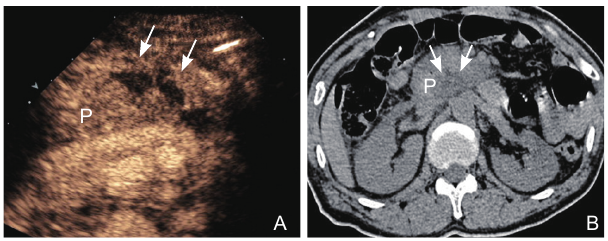
Figure 4 55-year-old man involved in a traffic accident. (A) CEUS identified the injury as an anechoic and hypoechoic perfusion defect with irregular borders in the pancreatic body/tail (arrows); (B) CT demonstrated the injury as a heterogenous, low-attenuation region (arrows) in the pancreatic body/tail, consistent with a hematoma and rupture of pancreas (P). [Provided by Dr. Faqin Lv from Third Medical Center of Chinese PLA General